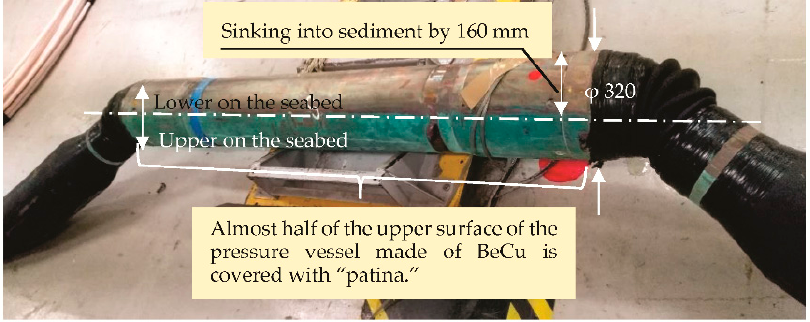
Figure 21. Appearance of recovered ‘’repeater C’’ from the water depths 5400 m.